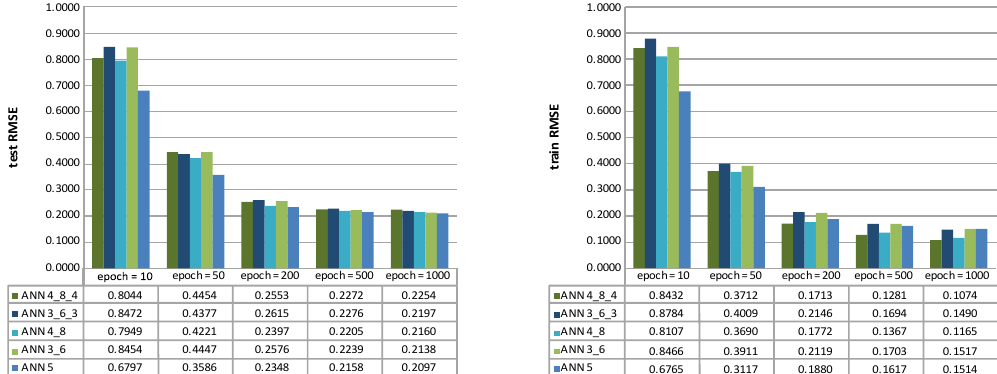
Figure 4. Test ( left ) and train MAE ( right ) of five different ANN topologies; ANN 5, ANN 3_5, ANN